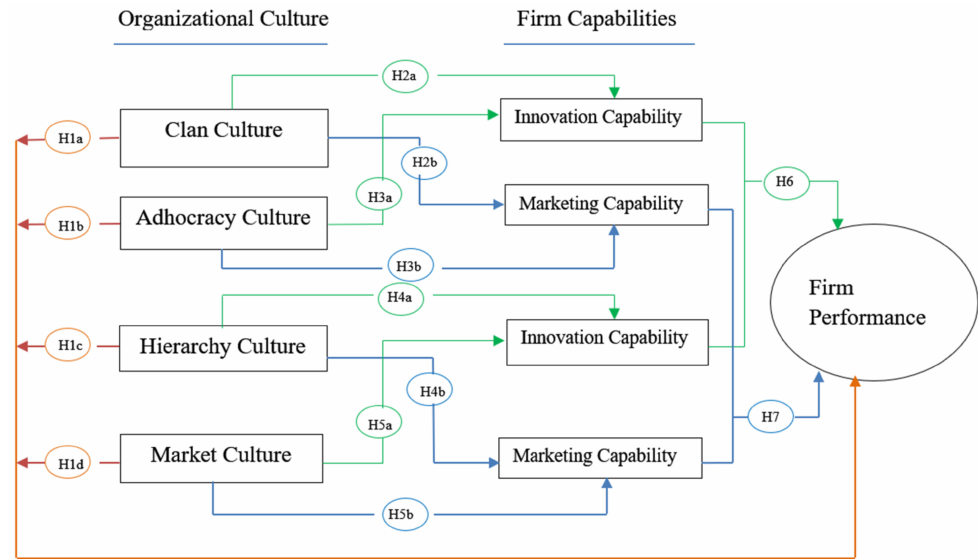
Figure 1. Research model and